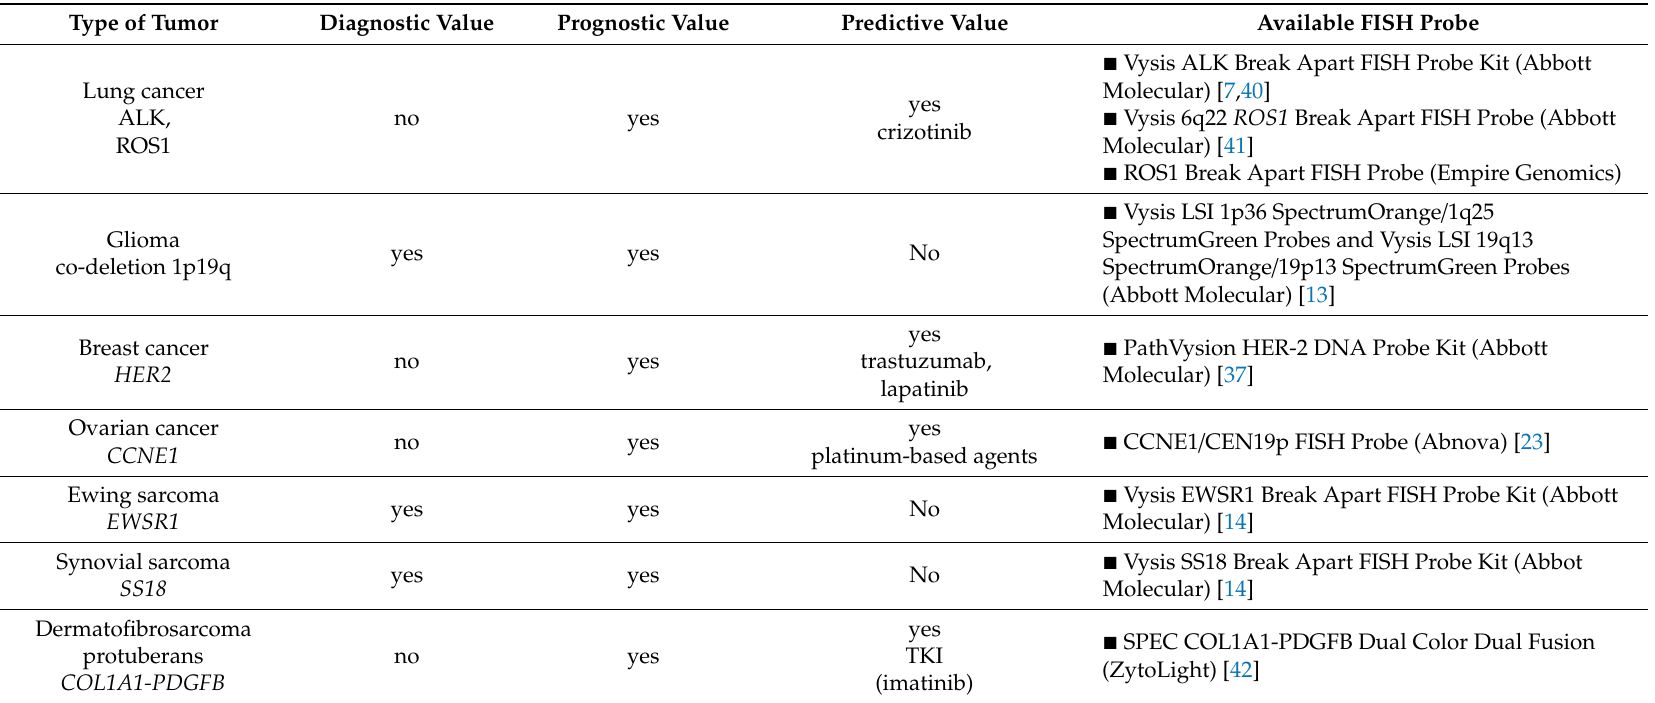
Table 2. Summary of FISH technique value in solid